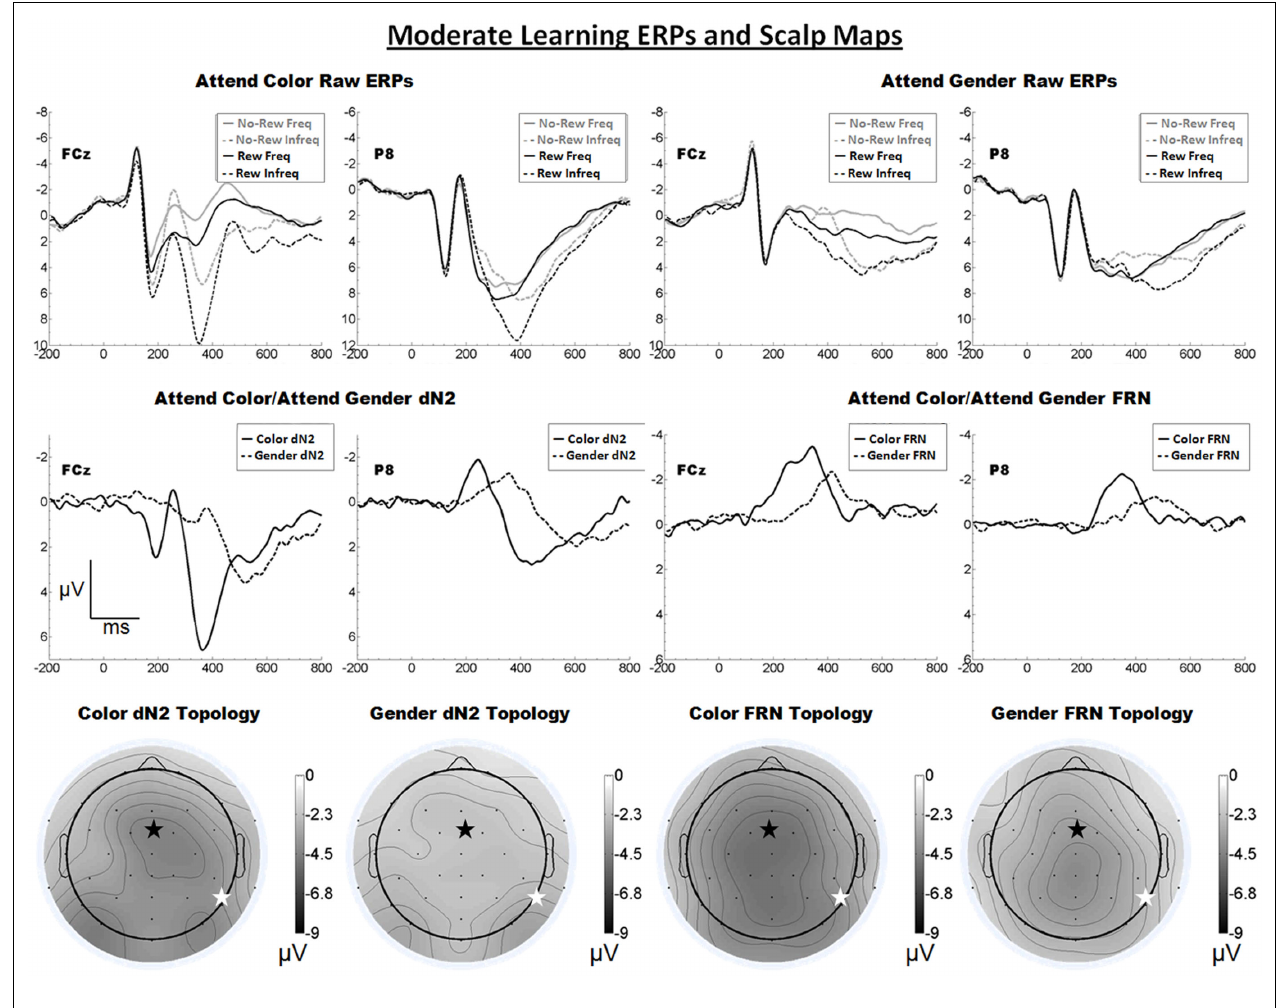
electrodes.The bottom row shows the scalp distributions of the dN2 and FRN across tasks.The scalp distributions reflect the base-to-peak measure of each of the dN2 and FRN.The black star on the scalp map denotes channel FCz, and the white star denotes P8. Note that negative is plotted